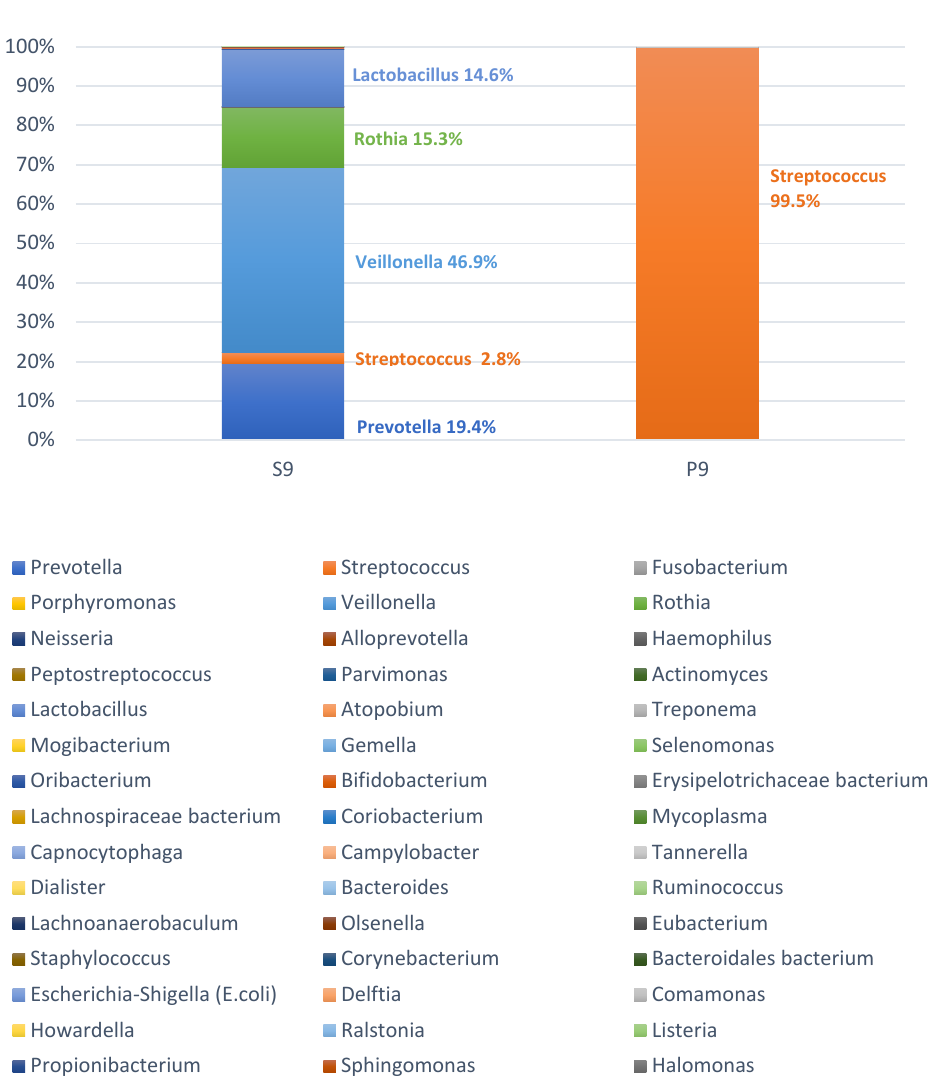
Figure 3. Microbiome of the saliva (S9) and the pus (P9) of patient no. 9. Herein, 99.5% of the reads belong to the genus Streptococcus and thus show the picture of a mono-infection. The legend contains all detected bacterial genera of the two related samples. The order in the legend corresponds to the total abundance in saliva and pus of all 50 samples (decreasing from left to right).